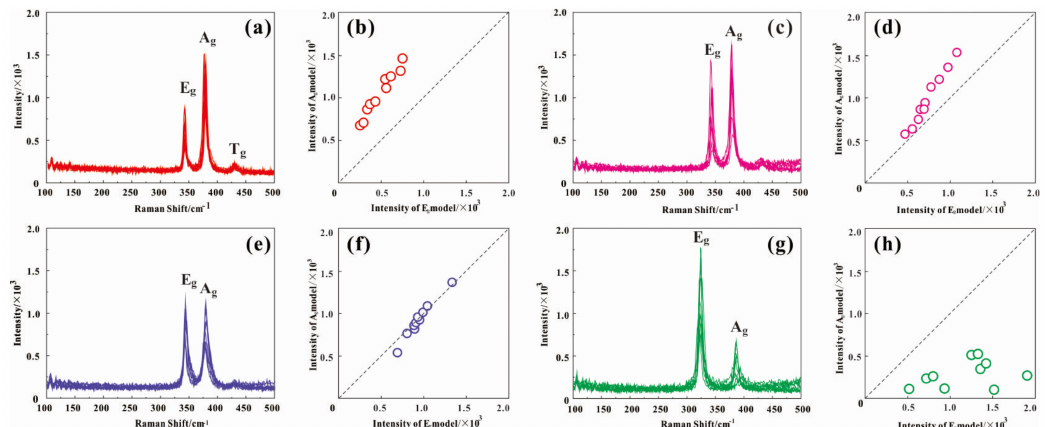
Figure 4. Raman spectra and correlogram of the Eg model and Ag model of the pyrites in ( a , b ) diabase